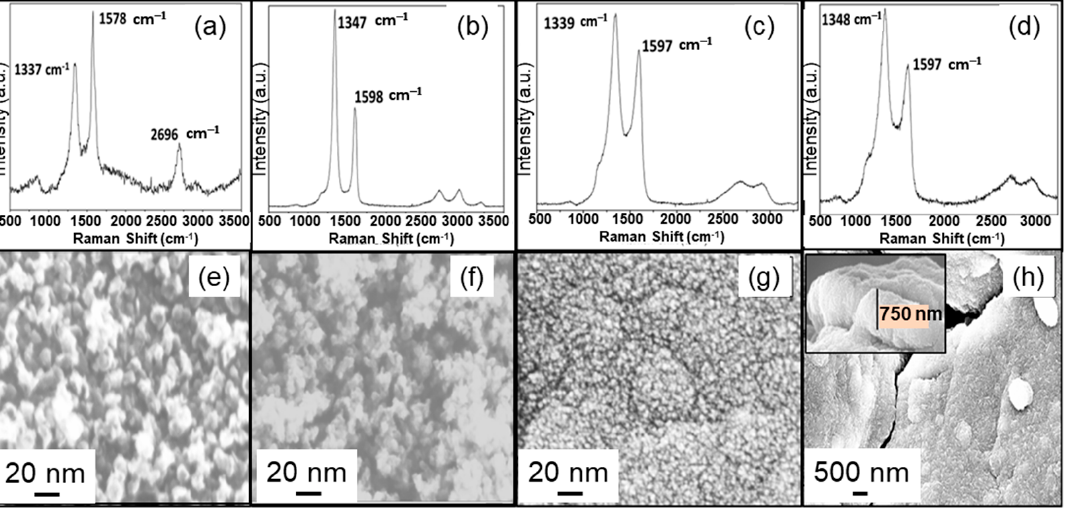
Figure 4. Raman spectrum (visible 532 nm laser beam wavelength) from N-UNCD films for sample 4 ( a ), sample 5 ( b ), sample 6 ( c ), and sample 7 ( d ). SEM plan-view ( e – h ) corresponds to films of samples 4, 5, 6, and 7, respectively. N-UNCD films for samples 4 and 5 were grown at 5 Torr and 625 °C and 675 °C substrate temperature, respectively at 3 cm from the filaments. N-UNCD related to samples 6 and 7 were grown at 10 Torr, 650 °C, at 2 cm from filaments. N-UNCD film for sample 7 was grown for 4 h.